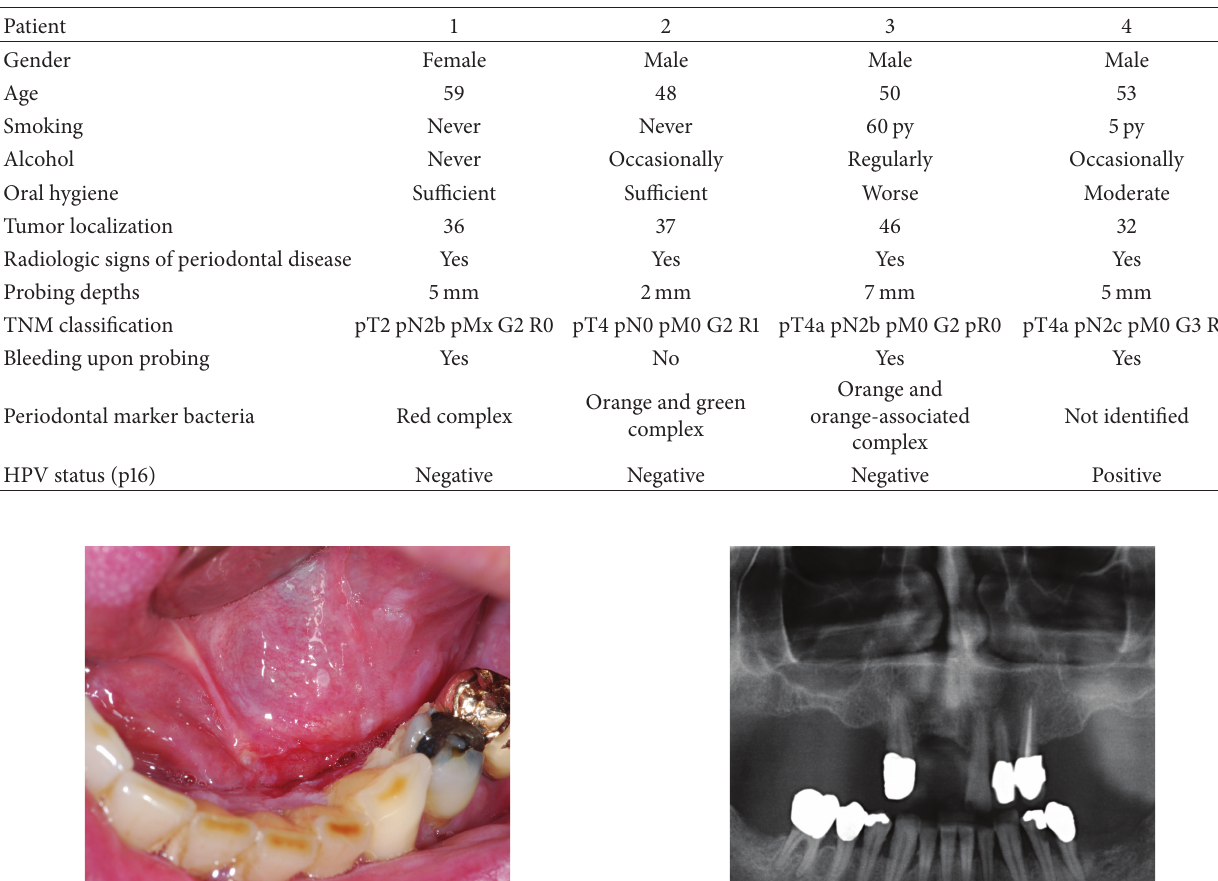
Table 1: Summary of the presented cases.